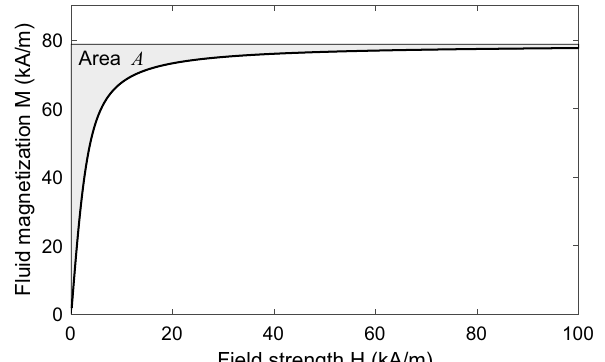
Figure 5. Ferrofluid magnetization curve, based on Langevin function with M s = 79 kA / m and H 0 = 1.41 kA/m.